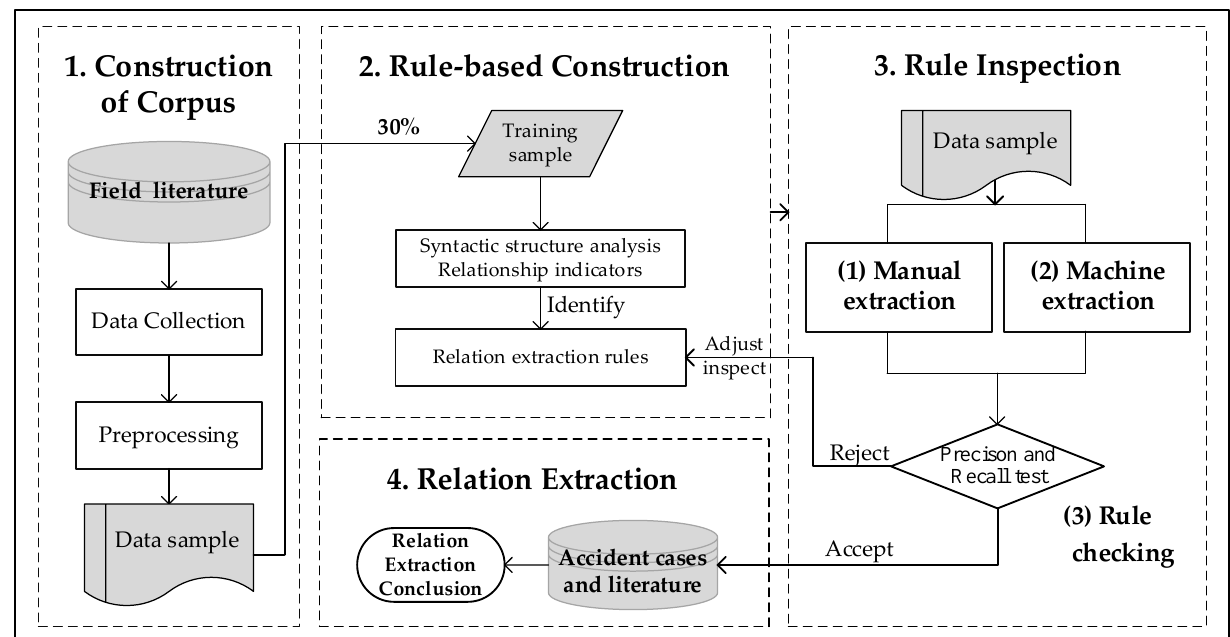
Figure 2. Rules-based Chinese NLP hierarchical relation extraction